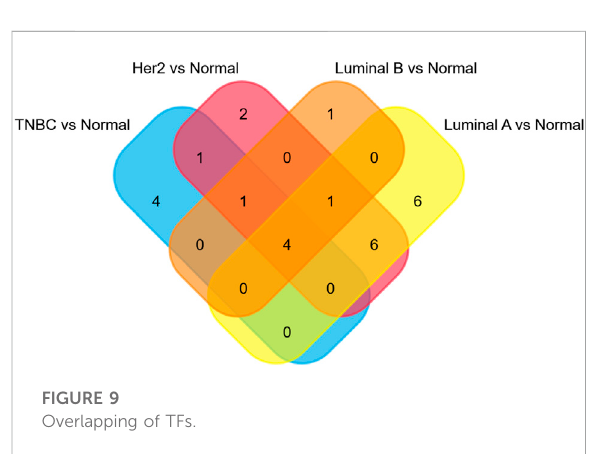
FIGURE 9 Overlapping of